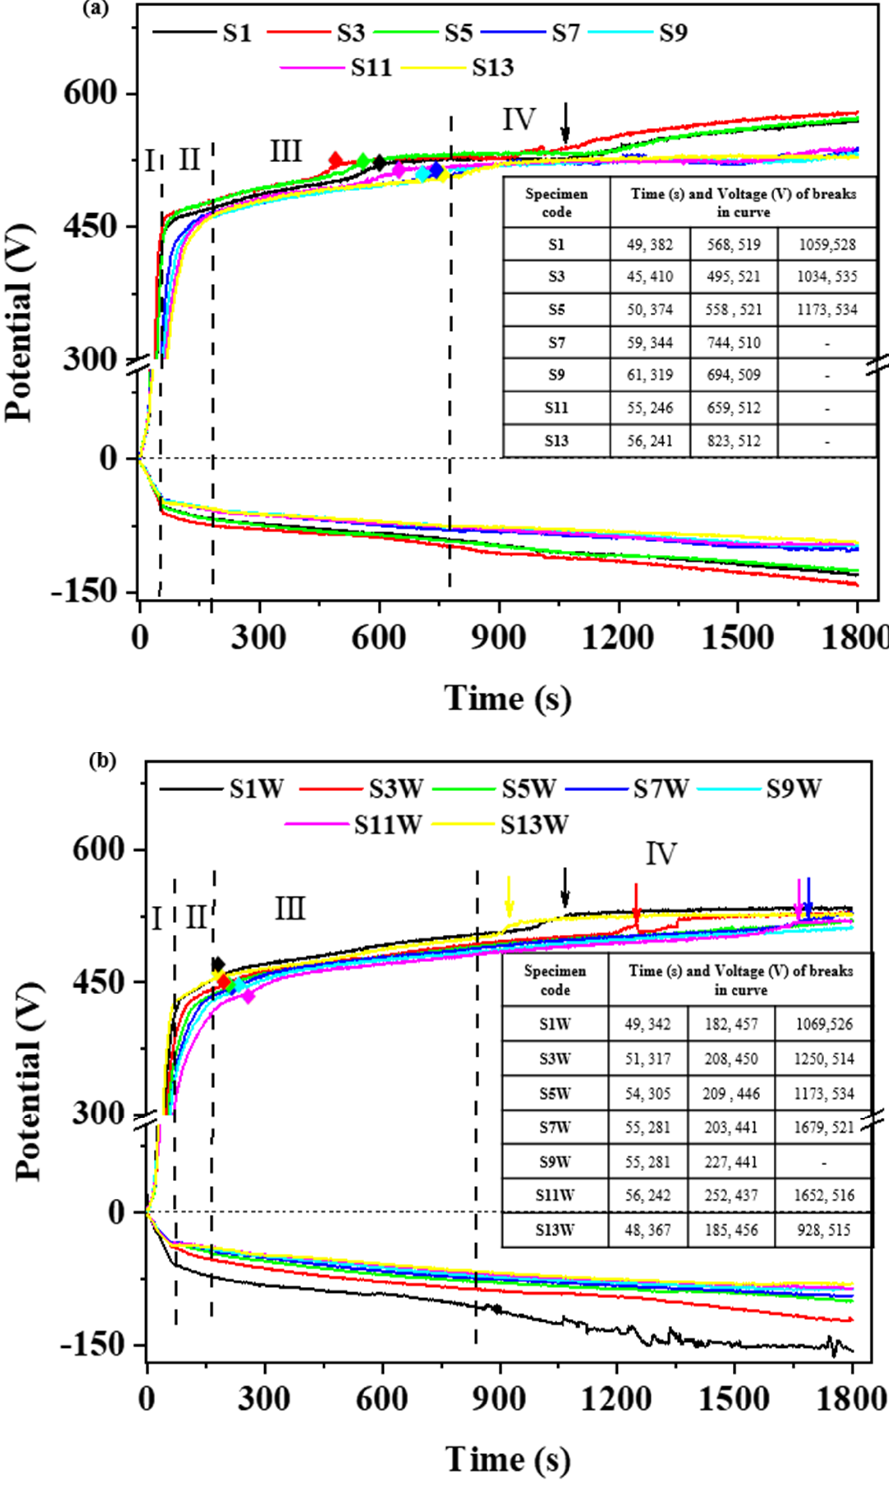
Figure 3. Voltage–time response curve recorded during the PEO process in the various coating solutions ( a ) without and ( b ) with Na2WO4 additive. The attached table presents the time and voltage of breaks in the curve of different PEO stages.